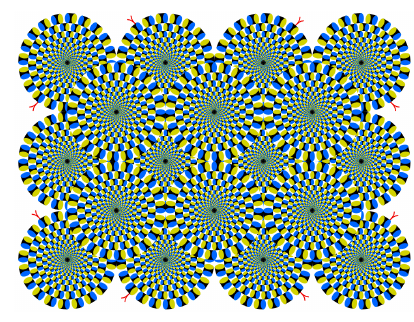
Figure 2. The dazzling graph of the referenced wall (ref: